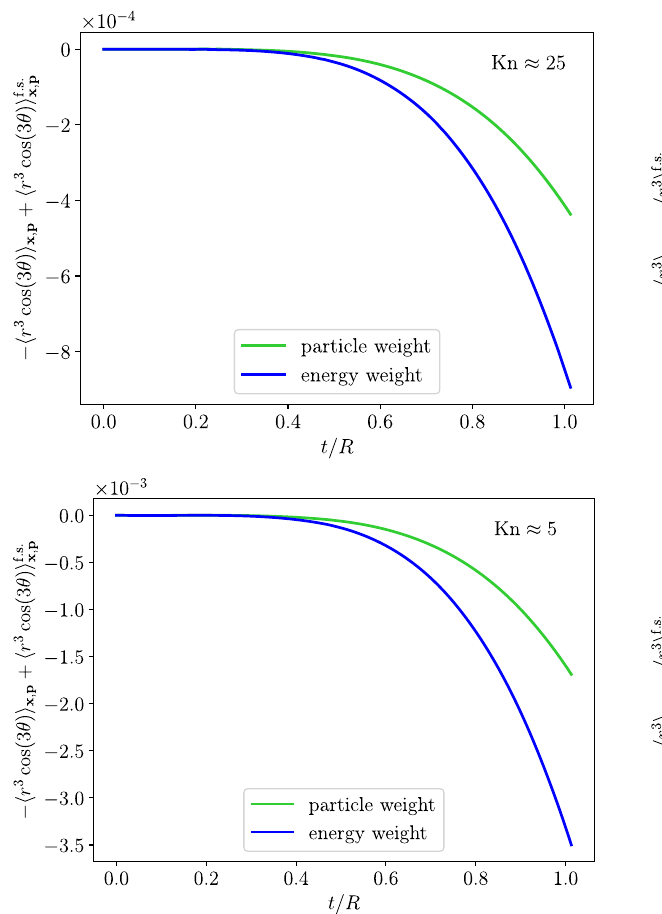
Fig. 16 Time evolution of the departure of (cid:3) r 3 (cid:4) x , p with particle- number (green) or energy (blue) weighting from its free streaming behavior, for simulations with Kn ≈ 25 (top panel) or Kn ≈ 5 (bottom